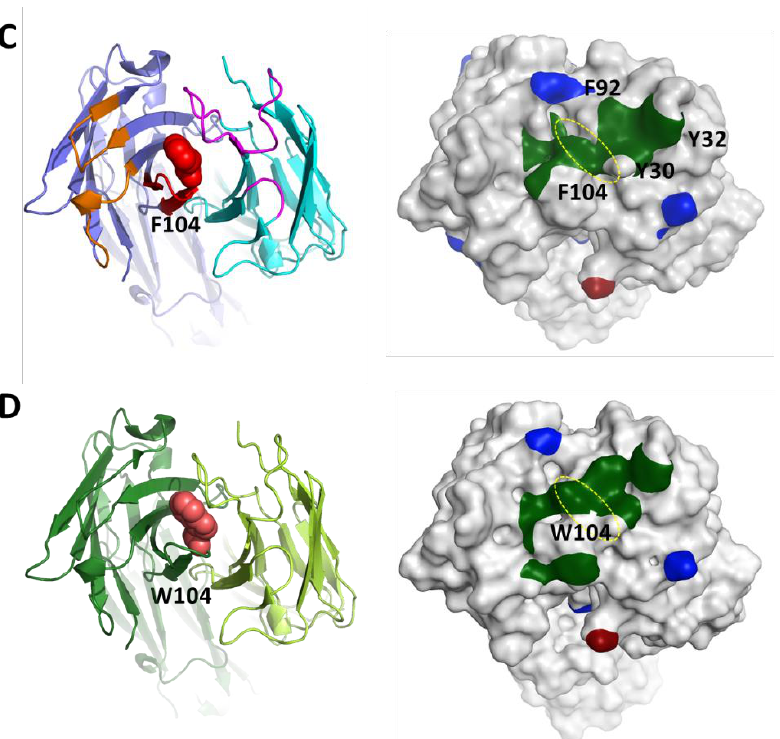
Figure 5. Fab homology models. ( A ) Model of HC:F104 Fab with VL in teal, VH in blue, VL CDR1-3 in purple, VH CDRs 1–2 in orange, VH CDR3 in red, and F104 in red spacefill. ( B ) Surface patch analysis of HC-F104 Fab homology model with hydrophobic patches in green, positive patches in blue, and negative patches in red. ( C , D ) Top view of CDR region of HC-F104 Fab and HC-W104 Fab homology models, respectively, rendered in Pymol. Left, ribbon depiction with F104 or W104 highlighted in red spacefill. Right, patch analysis rendered in MOE. F104 and W104 are circled with a dashed yellow ellipse.